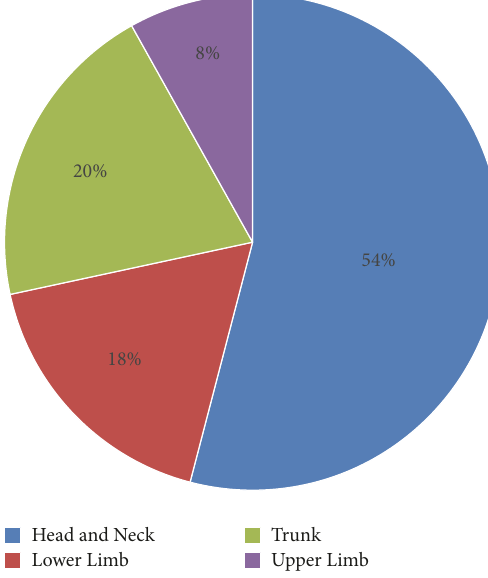
Figure 1: The most common area for BSC presentation was in the head and neck region (54% of cases), followed by the